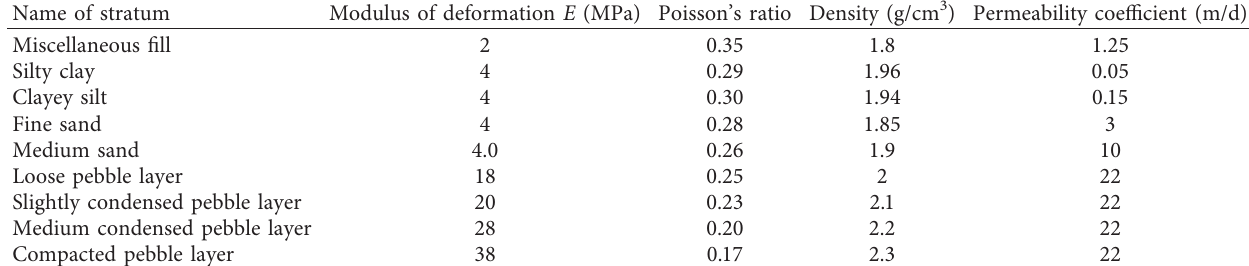
Table 2: Physical and mechanical parameters of strata.